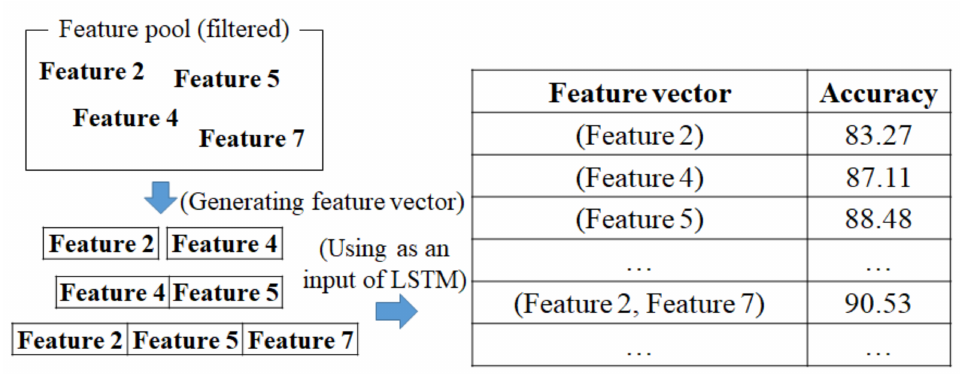
Figure 5. The procedure for choosing the fittest feature